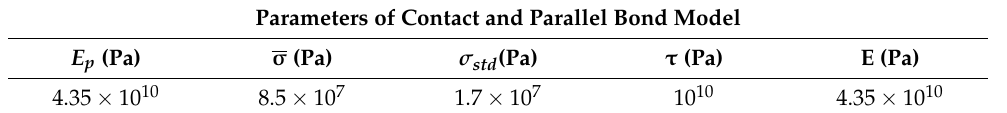
Table 2. Parameters of contact and parallel bond model. E, E p , σ , σ std , and τ are the contact effective modulus, parallel bond effective modulus, parallel bond mean tensile strength, parallel bond tensile strength standard deviation, and parallel bond shear strength.